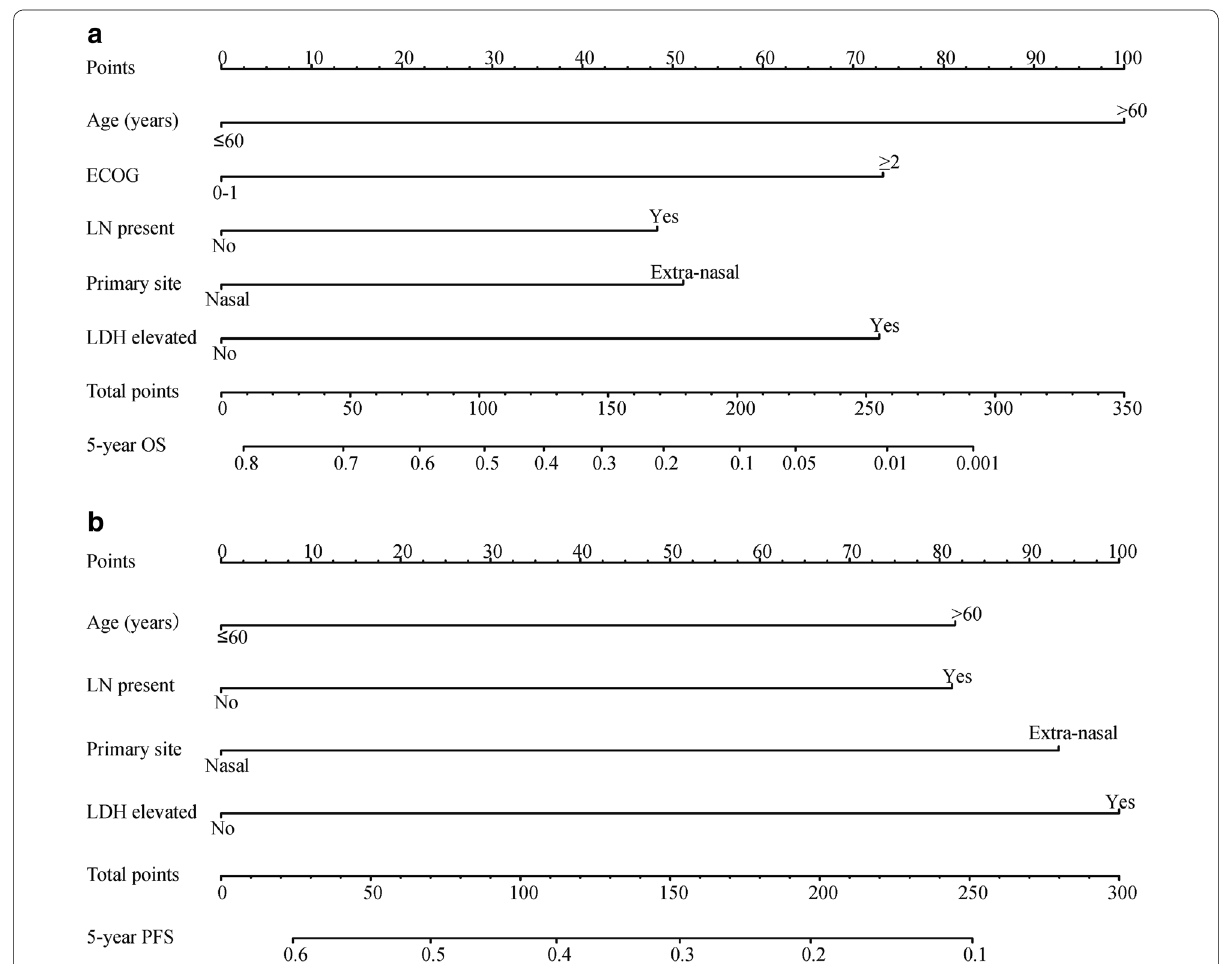
Fig. 4 A nomogram for patients with early‑stage upper aerodigestive tract natural killer/T‑cell lymphoma. To use the nomogram, an individual patient’s value is located on each variable axis, and a line is drawn upward to determine the number of points received for each variable value. The sum of these numbers is located on the total points axis, and a line is drawn downward to the survival axes to determine the likelihood of 5‑year OS ( a ) and PFS ( b ) rates. Site primary site of the lymphoma, LDH pretreatment level of serum lactate dehydrogenase, ECOG eastern cooperative oncol‑ ogy group, LN regional lymph